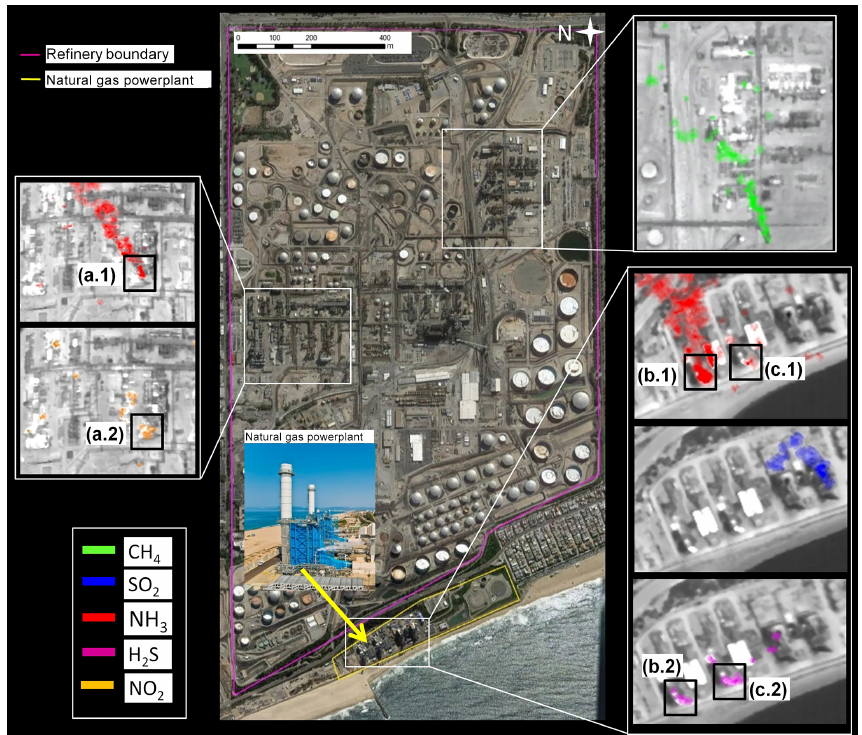
Figure 12. A HyTES multi-species gas detection example showing a Google Earth image (center) of the area covered by a HyTES flight line over a refinery (magenta outline) and a natural gas power plant (yellow outline) near El Segundo, CA. The insets show HyTES imagery of five detected trace gases (CH 4 , NO 2 , NH 3 , H 2 S, and SO 2 ) highlighted in different colors and overlayed on retrieved surface temperature data in grayscale. Three examples are indicated where two different gases were detected simultaneously within the same plume consisting of several contiguous pixels; NH 3 and NO 2 were detected over the refinery at the location a.1/a.2, while at the natural gas power plant, NH 3 and H 2 S were detected at location b.1/b.2, and c.1/c.2 respectively. Small plumes of SO 2 (blue) can also clearly be seen being emitted from areas of the power plant (inset photograph). A distinctive CH 4 plume was detected in the southeastern region of the